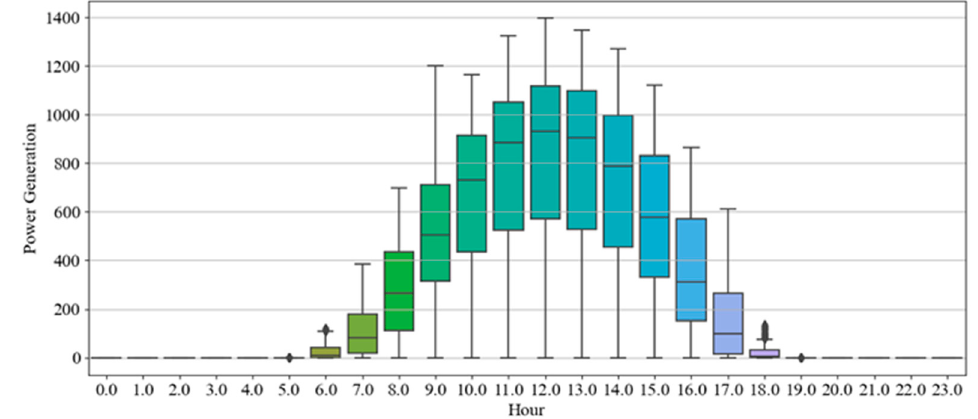
Figure 3. Solar panel power generation by hour Site B.